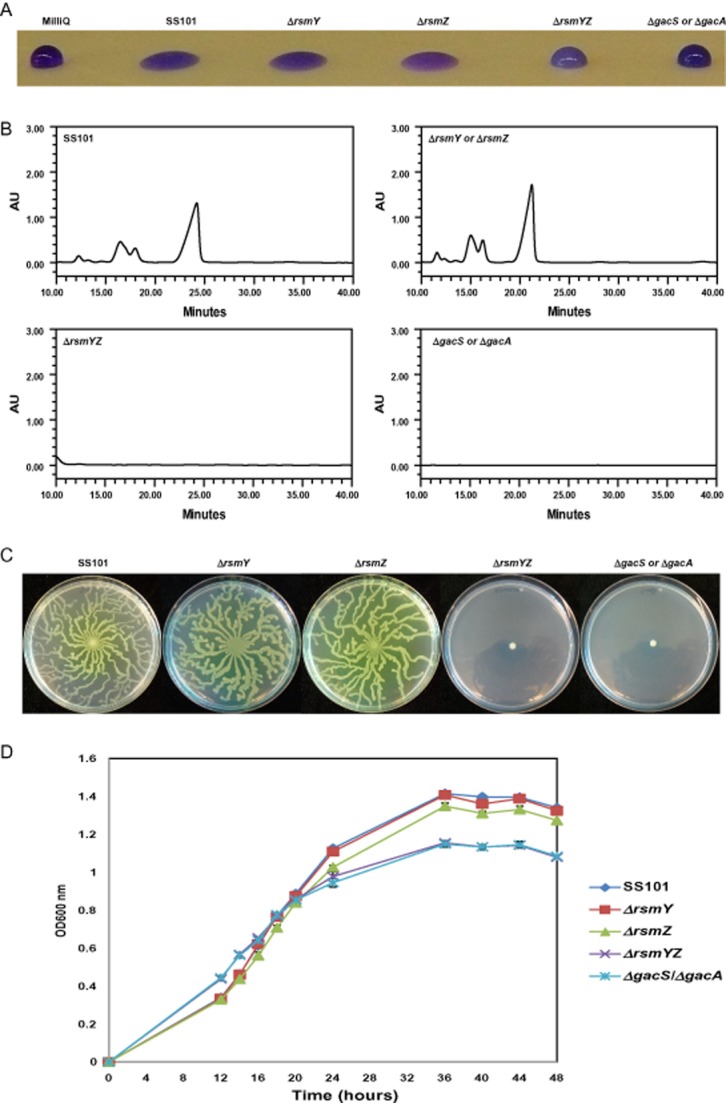
Phenotypic and chemical analyses of P. fluorescens strain SS101 and single or double mutants disrupted in rsmY, rsmZ, gacS or gacA.A. Drop collapse assay with cell cultures of wild-type strain SS101, ΔrsmY, ΔrsmZ, ΔrsmYZ, ΔgacS and ΔgacA mutants. Bacterial cultures grown for 2 days at 25°C on KB agar plates were suspended in sterile water to a final density of 1 × 1010 cells ml−1, and 10-μl droplets were spotted on parafilm, and crystal violet was added to the droplets to facilitate visual assessment. A flat droplet is a highly reliable proxy for the production of the surface-active lipopeptide massetolide A.B. Reversed phase-high-performance liquid chromatography chromatograms of cell-free culture extracts of wild-type strain SS101, ΔrsmY, ΔrsmZ, ΔrsmYZ, ΔgacS and ΔgacA mutants as described in A. The wild-type strain SS101 produces massetolide A (retention time of approximately 23–25 min) and various other derivatives of massetolide A (minor peaks with retention times ranging from 12 to 18 min) which differ from massetolide A in the amino acid composition of the peptide moiety. AU stands for absorbance unit.C. Swarming motility of wild-type strain SS101, ΔrsmY, ΔrsmZ, ΔrsmYZ, ΔgacS and ΔgacA mutants on soft [0.6% (wt/vol)] agar plates. Five microlitres (1 × 1010 cells ml−1) of washed overnight cultures of wild-type SS101 or mutants were spot inoculated in the centre of a soft agar plate and incubated for 48 to 72 h at 25°C.D. Growth of wild-type strain SS101, ΔrsmY, ΔrsmZ, ΔrsmYZ, ΔgacS and ΔgacA mutants in liquid broth at 25°C. At different time points, the optical density of the cell cultures was measured spectrophotometrically (600 nm). Mean values of four biological replicates are given; the error bars represent the standard error of the mean.